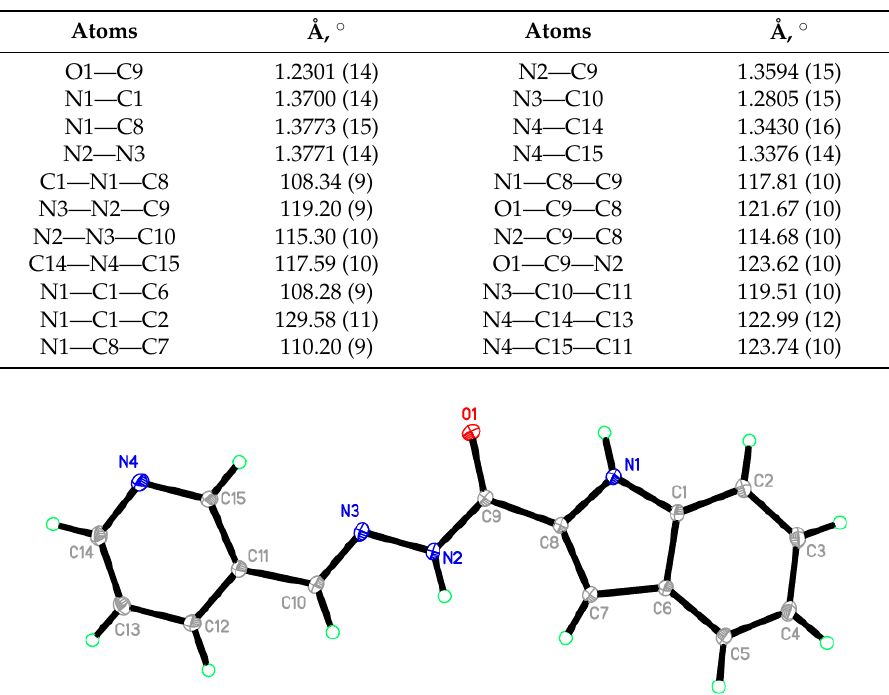
Table 3. Selected bond lengths and bond angles in compound 13 .